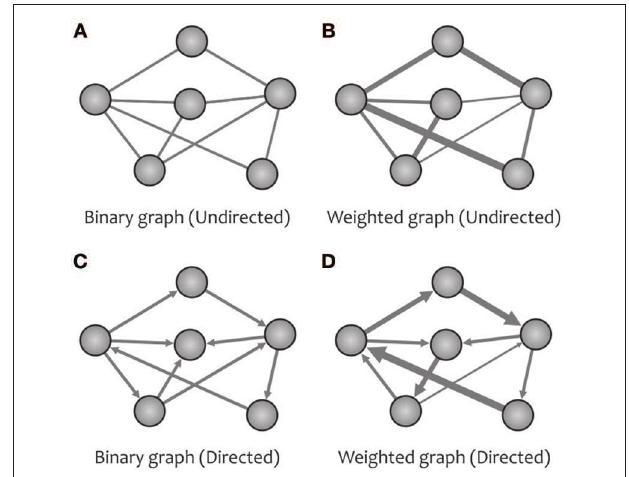
FIGURE 2 | A network can be designed as binary (A) or weighted (B) graphs, and can represent the direction of causal effects (C,D) among different